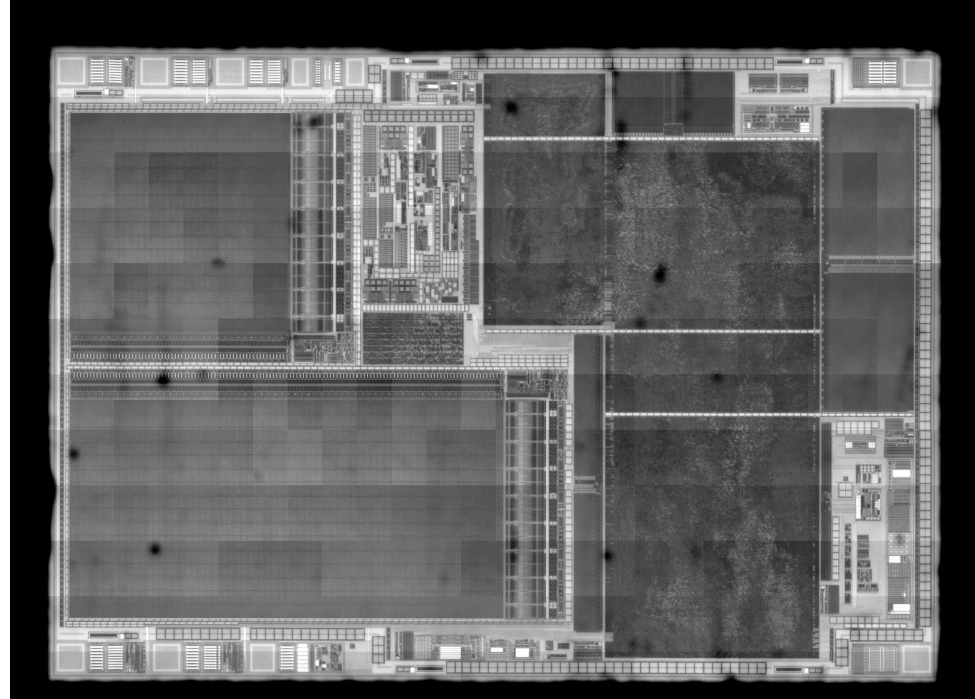
Figure 9. Resulting scan of conductive tracks (the of Interest (SOI) inside an IC under infrared microscope magnification 20 × . The black spots correspond to contaminants present on the silicon surface. The small intensity gap between the mosaic images is camera